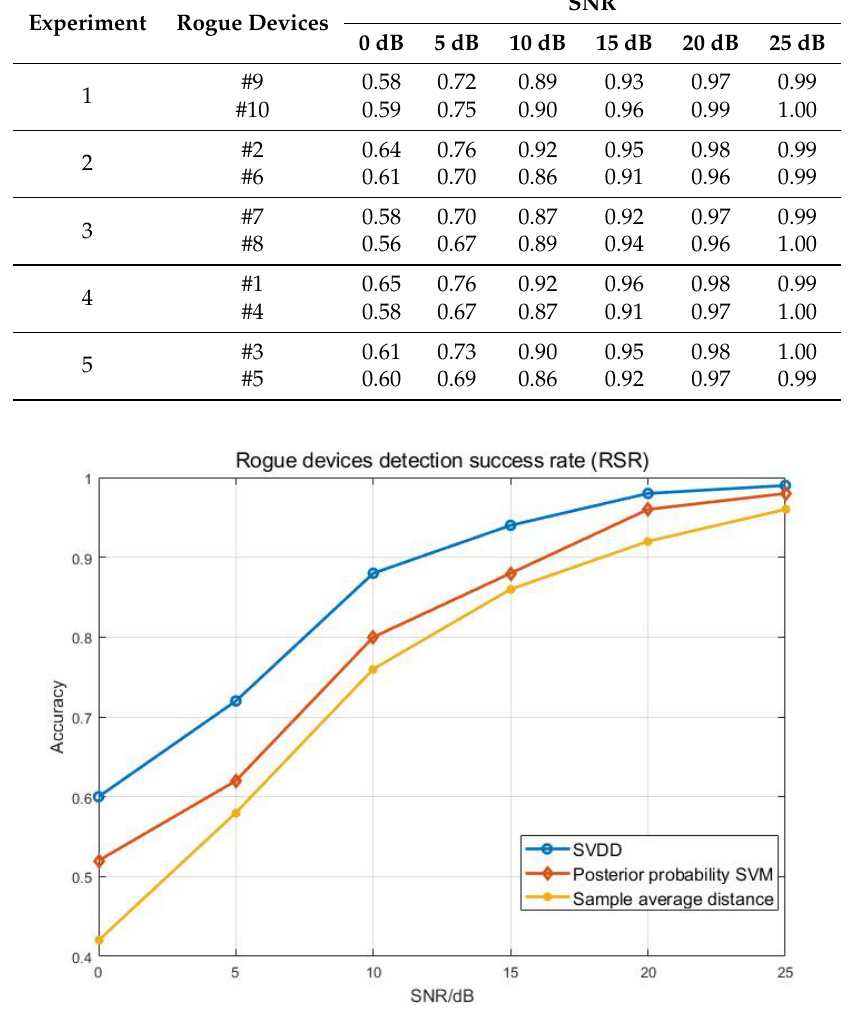
Figure 9. Rogue device detection success